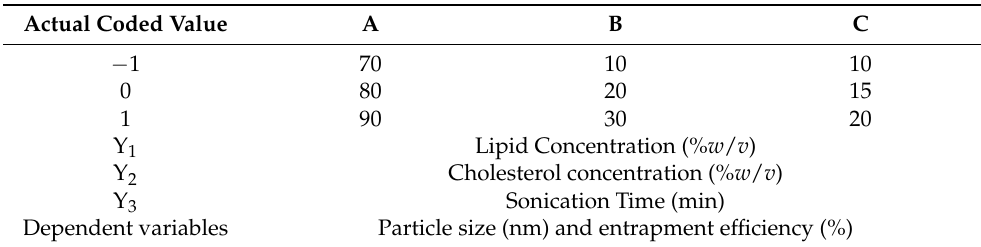
Table 1. Independent variables with their responses and